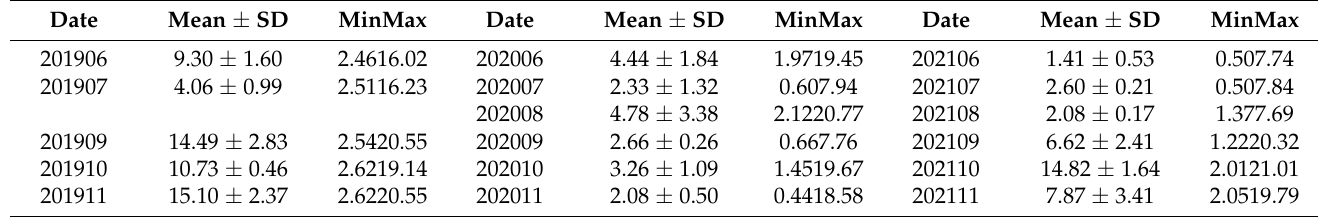
Table 2. Mean, maximum, minimum, and standard deviation of Chl-a concentration (unit: µ g/L) in GF-6 WFV images of Xiao Xingkai Lake.